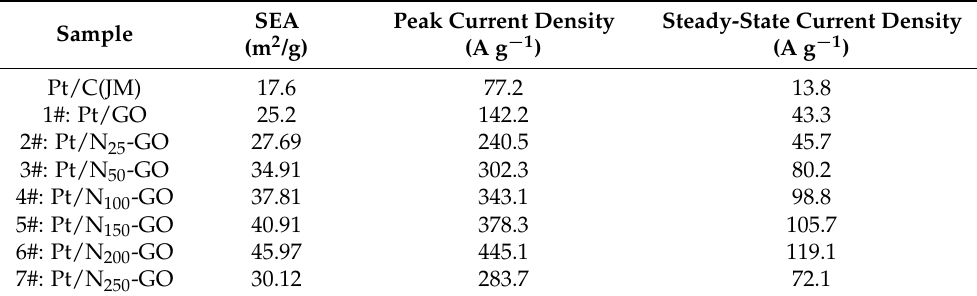
Figure 6. Cyclic voltammetric curves of catalysts in 0.5 mol/L H 2 SO 4 solution. Table 2. Electrochemical activity of Surface area, peak current densities and steady-state current densities recorded for the catalysts.